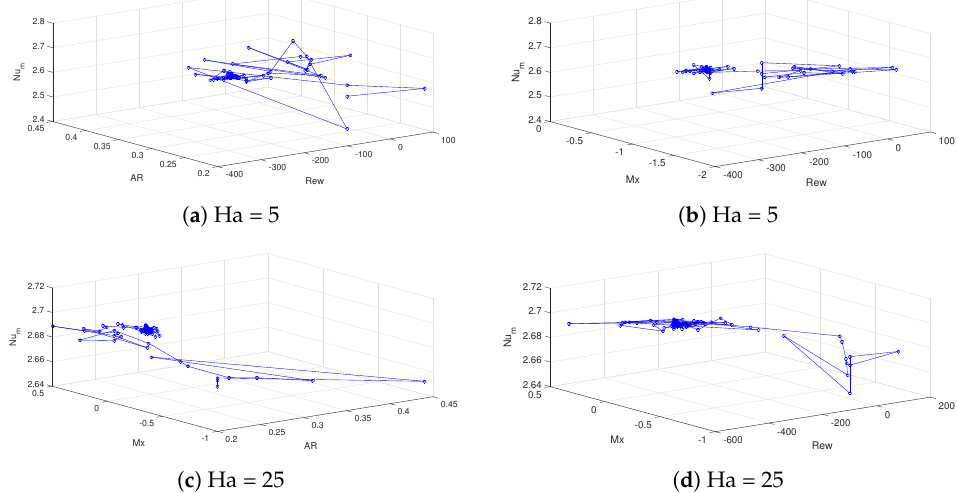
Figure 14. Search forthe maximal average Nu with the optimization solver at ( a , b ) Ha = 5 and ( c , d ) Ha =